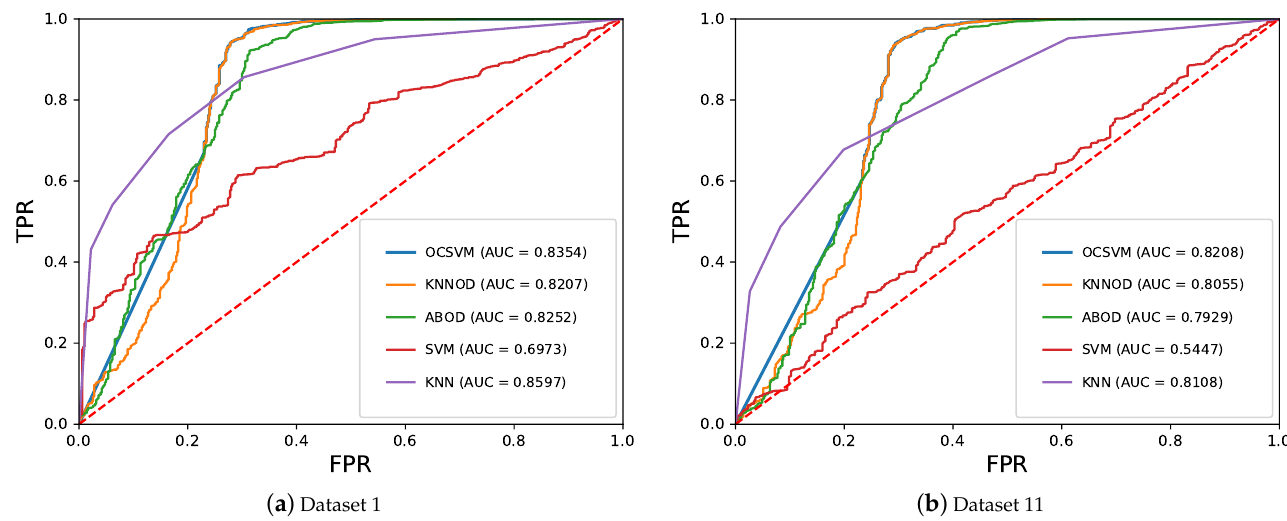
Figure 13. Examples of ROC curves obtained by semi-supervised and supervised algorithms using all features on datasets 1 and 11 in one run of the experiment.